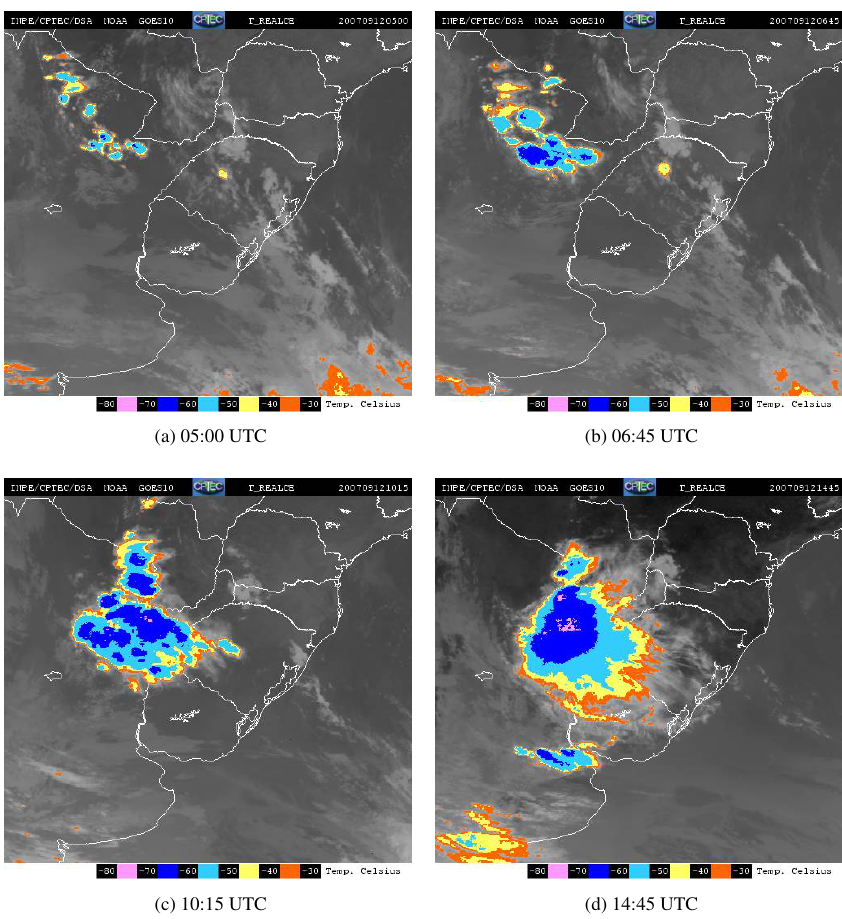
Fig. 5. Enhanced infrared satellite images from GOES 10 for an MCS evolution on 12 September 2007 over the La Plata Basin. Colors indicate infrared temperatures. (a) 05:00UTC, (b) 06:45UTC, (c) 10:15UTC, and (d) 14:45UTC.